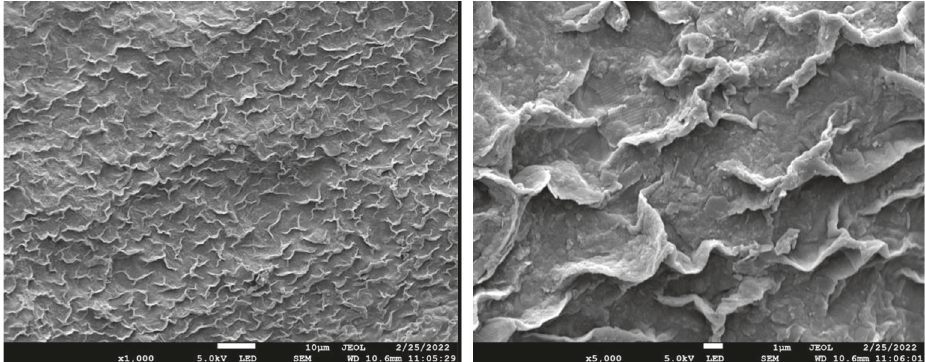
Figure 4: Scanning electron microscopy (SEM) images of Ceramium rubrum at 10 μ m and 1 μ m.